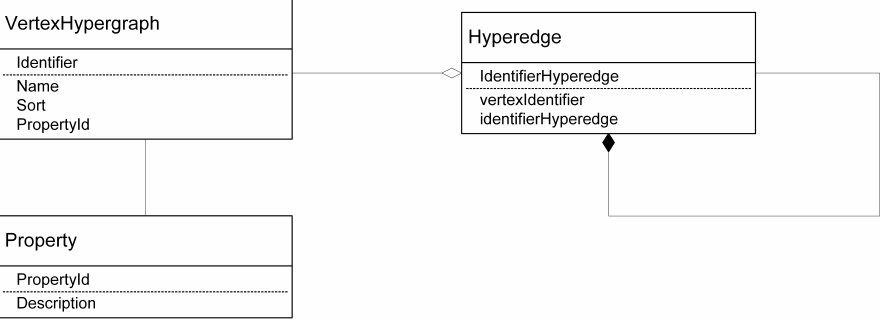
Figure 5. Representation at the implementation level of vertices in a hyper-graph. Table 4. Incidence matrix for the bipartite graph example in Figure